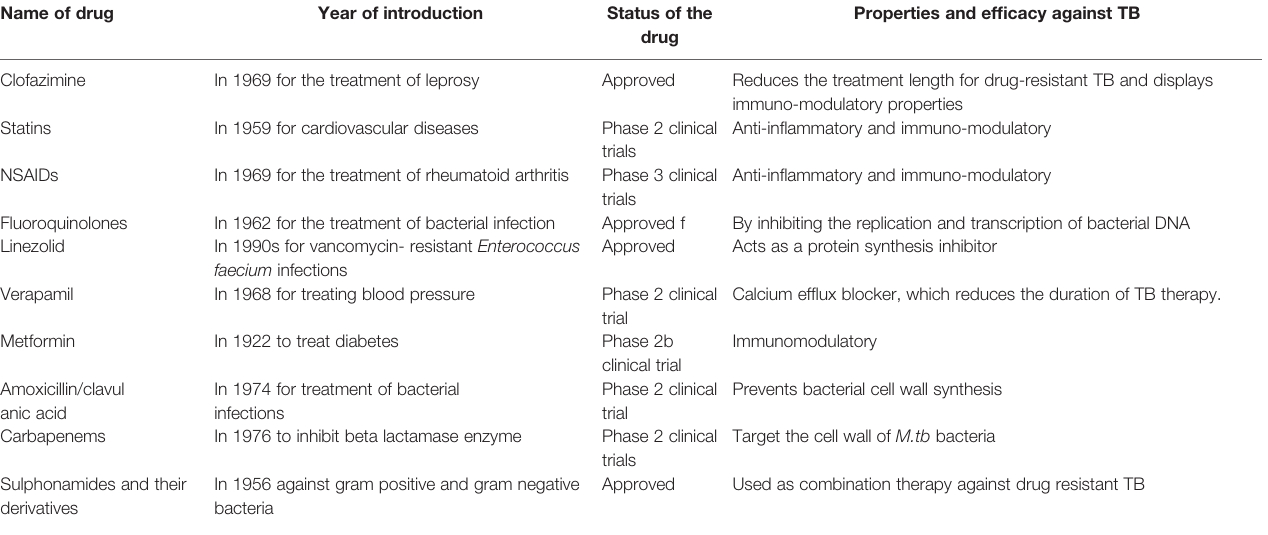
TABLE 1 | Repurposed drugs with their year of introduction and status in TB treatment.